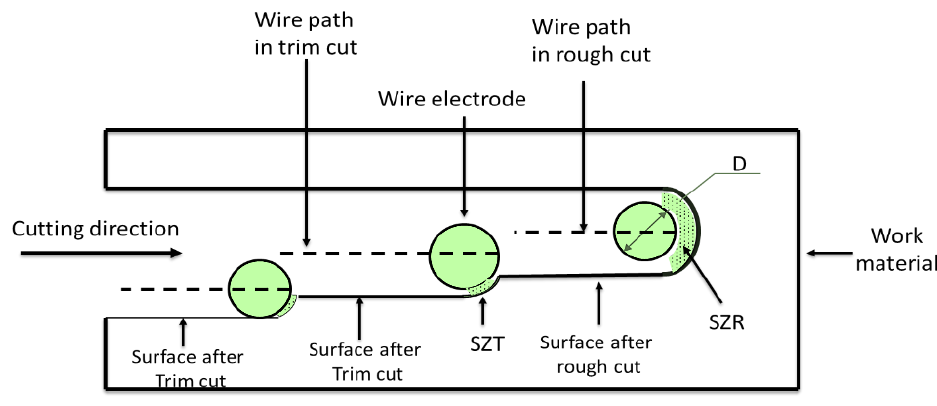
Figure 5. The principal of rough and trim cut modes of WEDM, reproduced, with permission from Springer (1293523) [18].